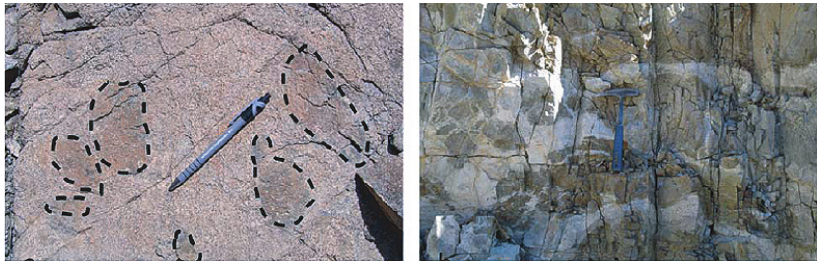
Figure 5. Gabbros intruding and stoping blocks of hydrothermally altered sheeted dikes in the Wadi Gideah section of the Wadi Tayin massif. Studies of such dike-gabbro transitions will provide essential information on the nature of heat and mass transfer between oceanic lower crust, upper crust, and the oceans. From France et al.